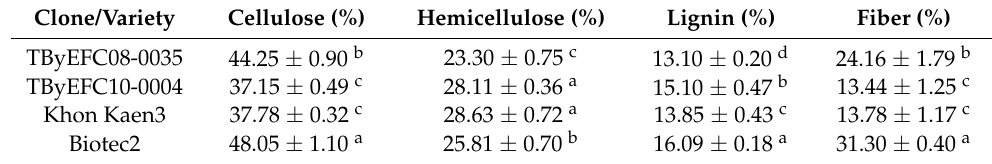
Table 2. Chemicalcompositionandfibercontentofrawbagassefromenergycaneclonesandcontrolvarieties.